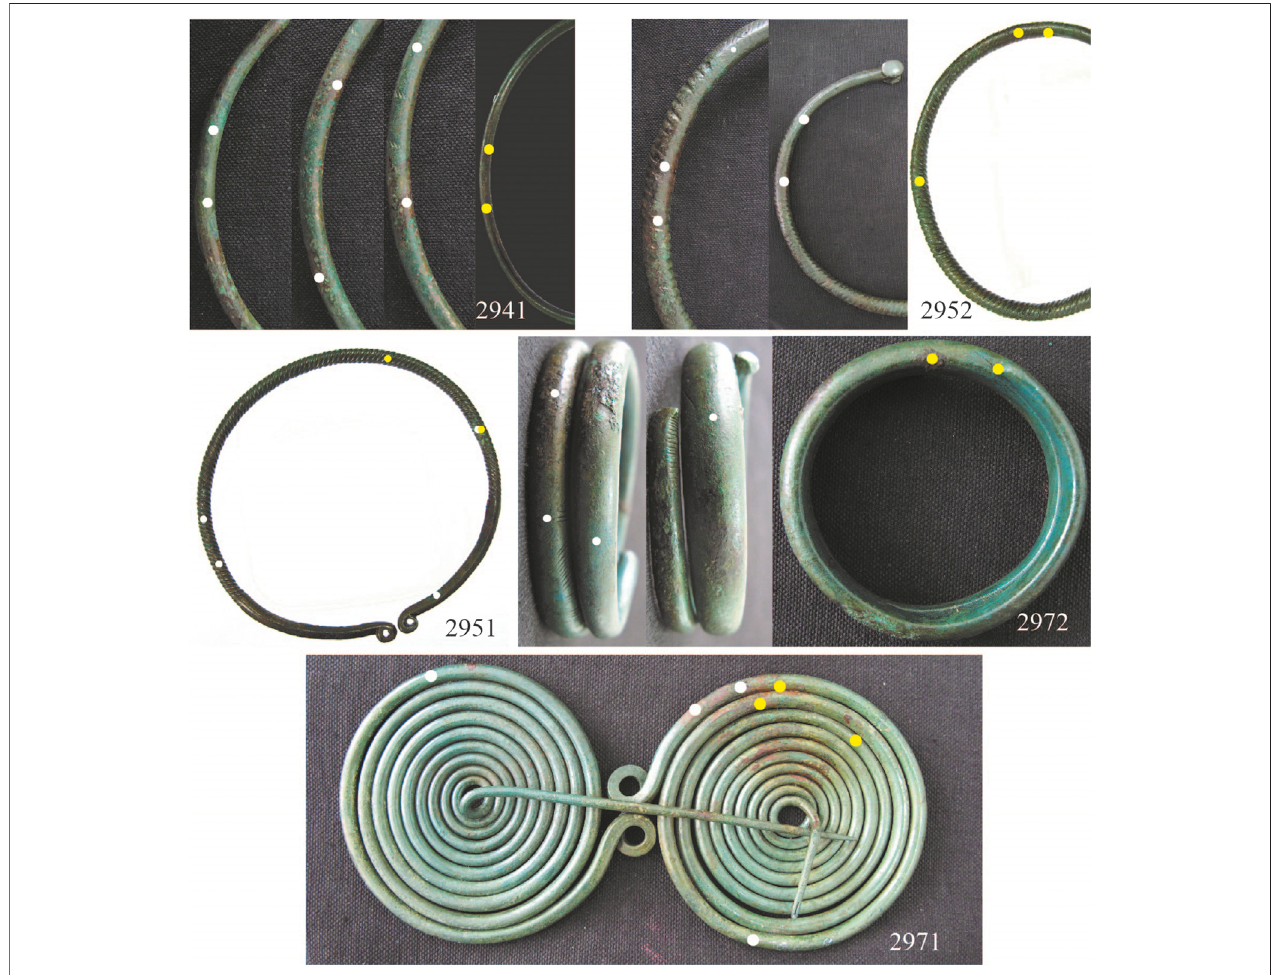
FIGURE 5 | Location of the analysis areas. XRF areas are marked with white circles and LIBS areas are marked with yellow circles.